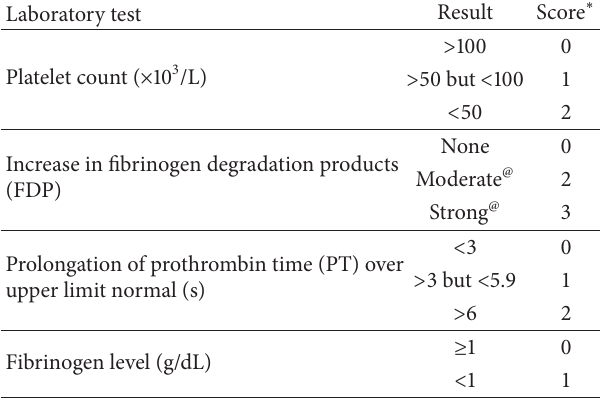
Table 1: International Society of Thrombosis and Hemostasis criteria for overt